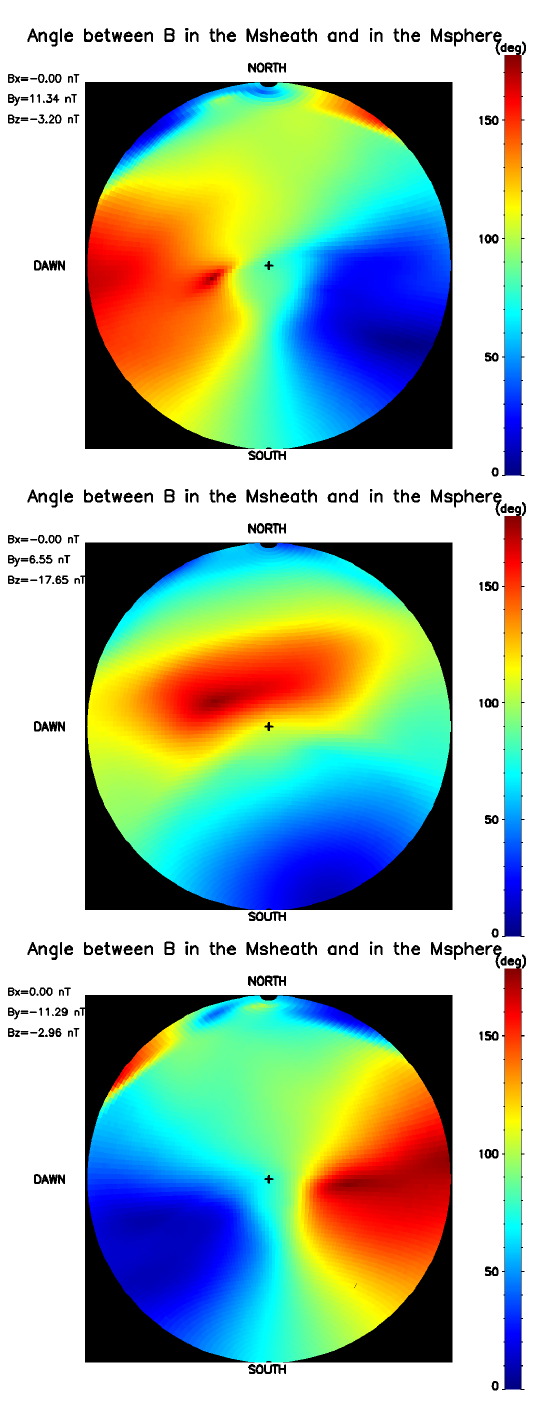
Fig. 11. Colour maps of the shear angle along the magnetopause during the central crossing of a fully south MC. See the caption of Fig. 9 for details. Top panel: at the beginning of the MC ( x = 3000 R E ) – middle panel: in the core of the MC ( x = 1000 R E ) – bottom panel: at the end of the MC ( x = − 3000 R E